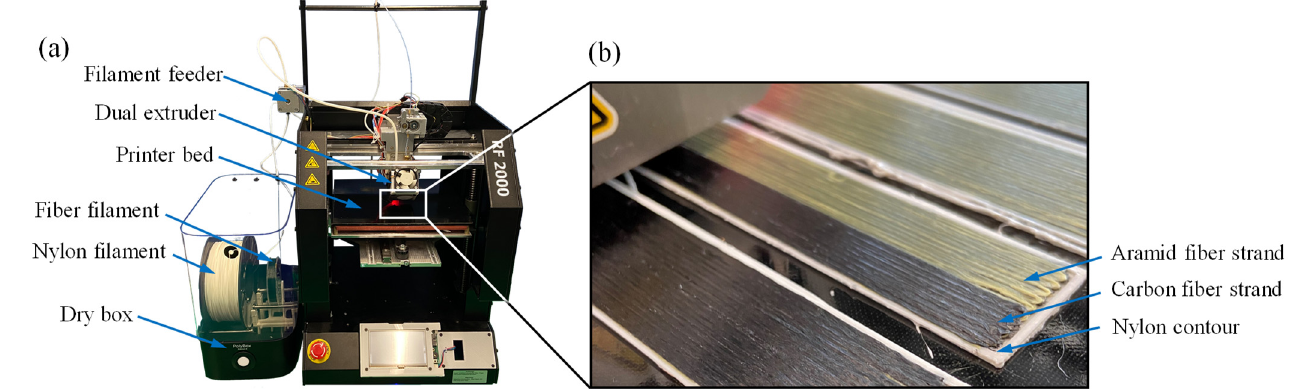
Figure 3. ( a ) Renkforce RF2000 with Markforged Dual Extruder and with Polymaker Polybox TM ; ( b ) printing process during the deposition of carbon fiber strands on an aramid fiber layer.